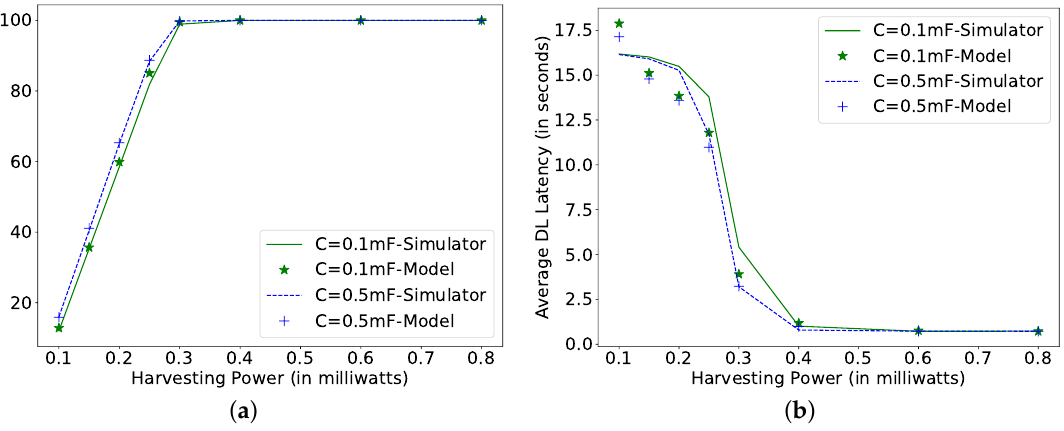
Figure 9. Comparing simulator and model for different harvesting powers at µ p = 1 s, T PI = 1 s, N = 16, T AT = 0 ms. ( a ) Average packet delivery ratio; ( b ) DL